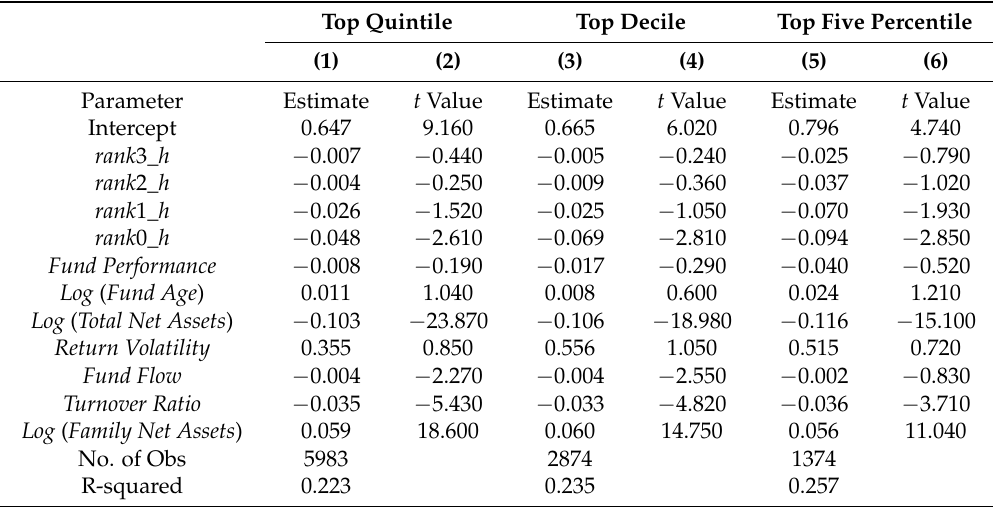
Table 5. The impact of competition on the marketing expenses of top-performing funds. Top Quintile Top